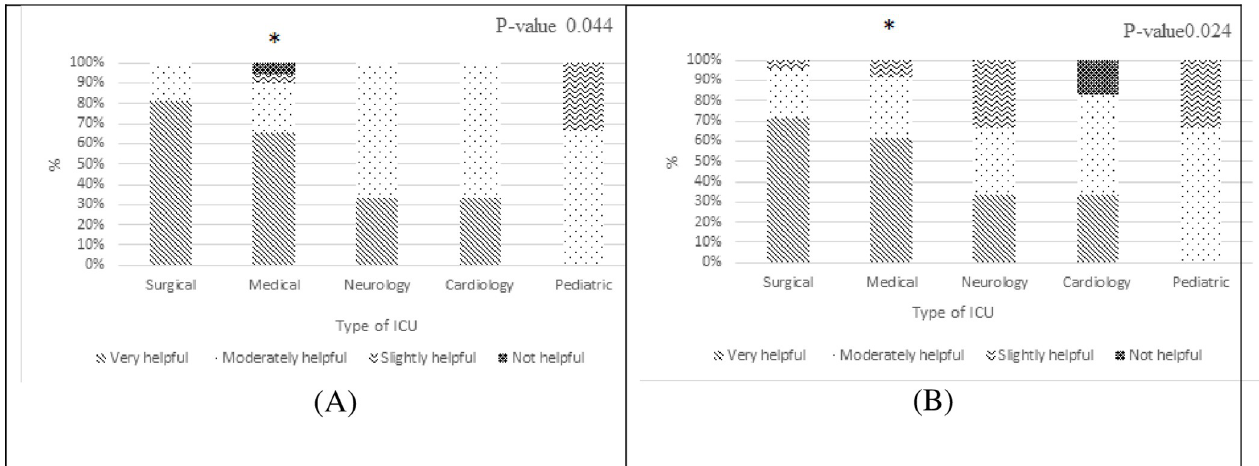
Fig 8. The significant relationship between type of ICU and the following interventions (A) of an advice from an infectious disease specialist (B) availability of locally developed guidelines for therapy of infections intervention. ( � significant p -value < 0.05 compared to surgical, neurology, cardiology, pediatric).